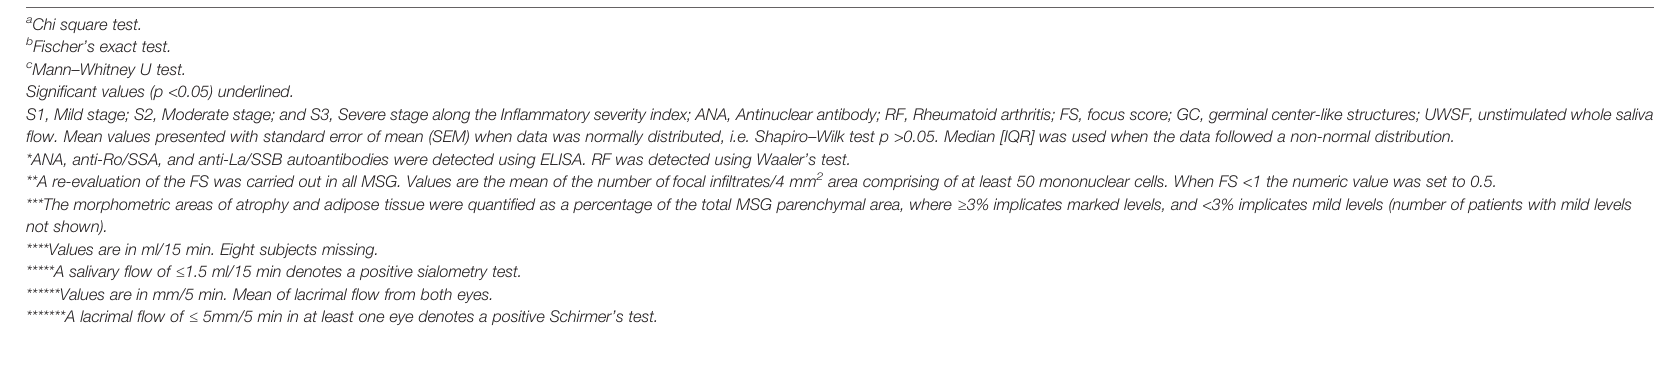
a Chi square test. b Fischer ’ s exact